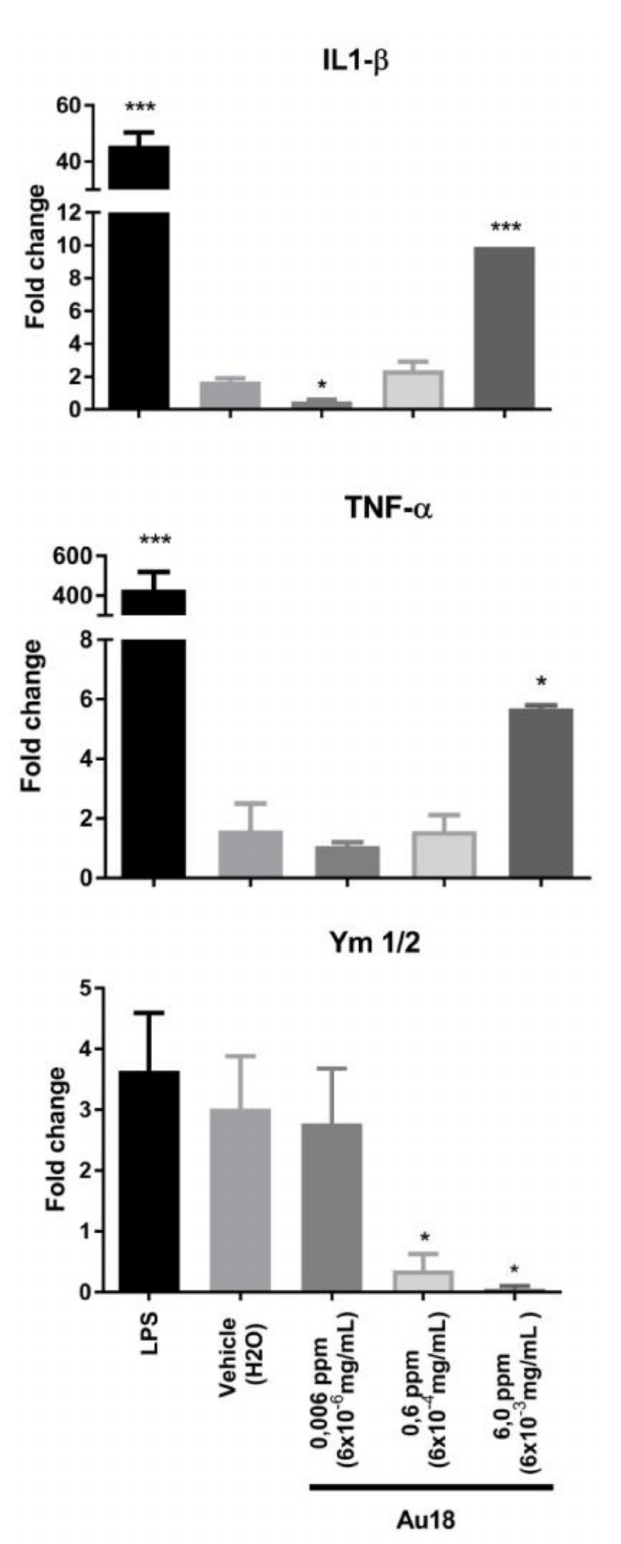
Figure 3. Inflammatory responses of mouse primary microglia cells in response to Au18 NCs. Primary microglia cells were treated with Au18 NCs (0.006 ppm, 0.6 ppm, 6.0 ppm) or lypopolysaccharyde (LPS) (125 ng/mL) and cultured during 3 h. The expression of interleukin 1- β (IL-1 β ), tumor necrosis factor (TNF- α ) and Ym1/2 was examined using RT-qPCR ( n = 3/group, * p < 0.05; *** p < 0.001 as compare to untreated